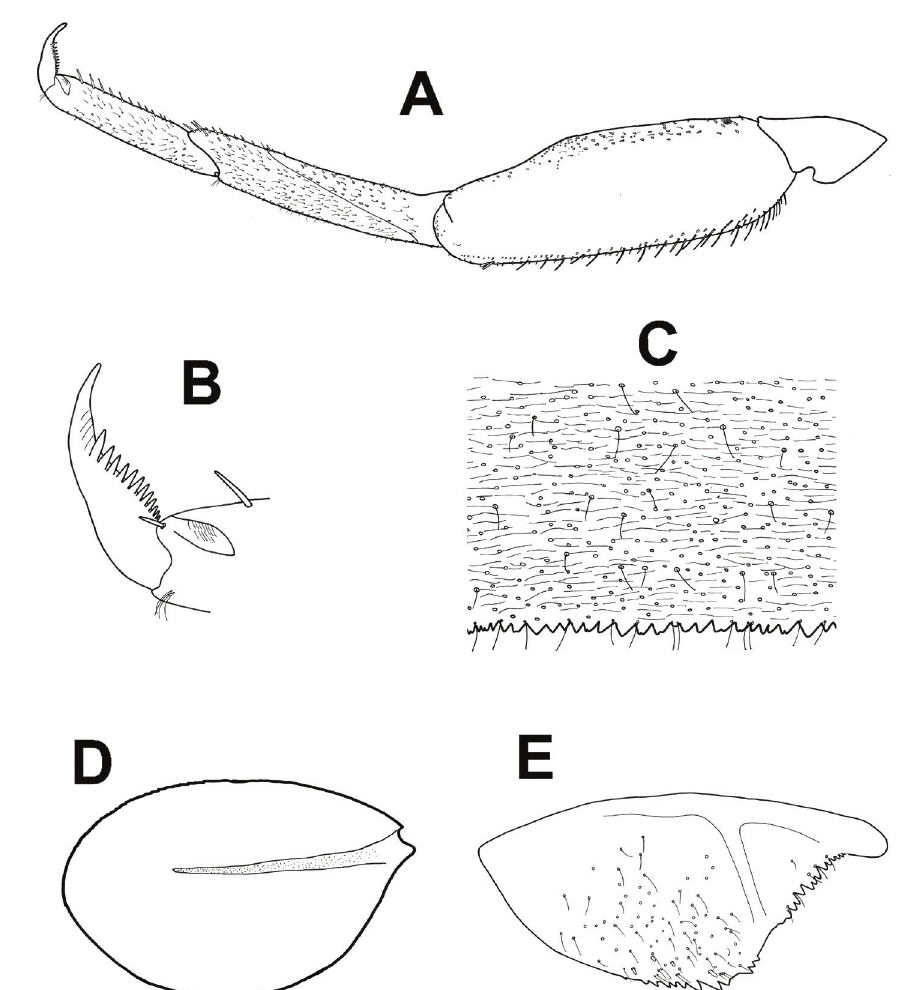
Figure 11. Baetis monnerati , nymph. A foreleg B tarsal claw C abdominal tergum V, surface and distal margin D gill IV E paraproct plate. Reproduced with permission from Gattolliat et al.